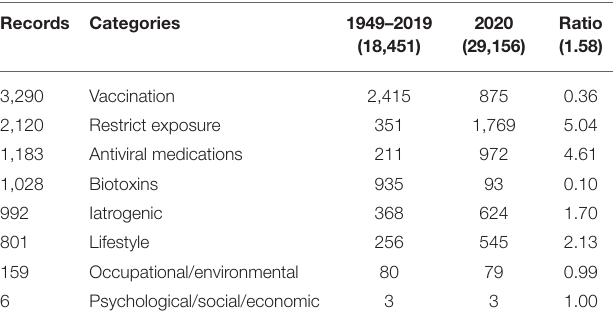
TABLE 4 | Shifting frequency of attention to various approaches regarding